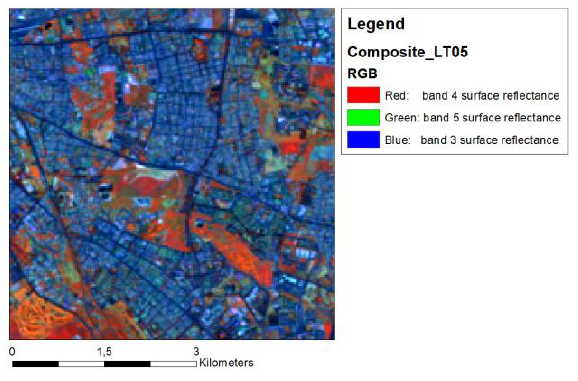
Figure 10. colour composite of a Landsat 4-5 TM